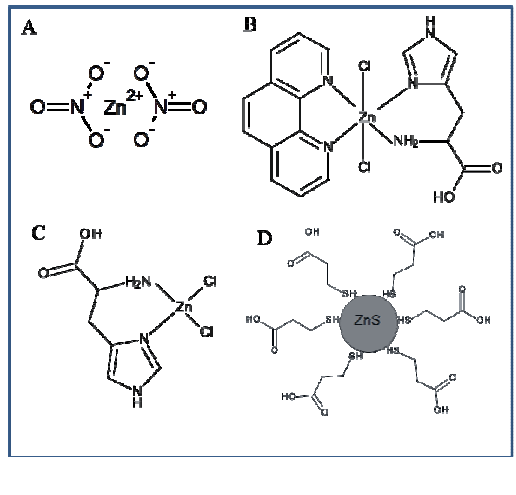
Figure 9. Structure of ( A ) Zinc nitrate and suggested structure of zinc complexes as ( B ) Zn(phen)(his)Cl , ( C ) Zn(his)Cl and ( D ) ZnS QDs covered with 3-mercaptopropionic 2 2